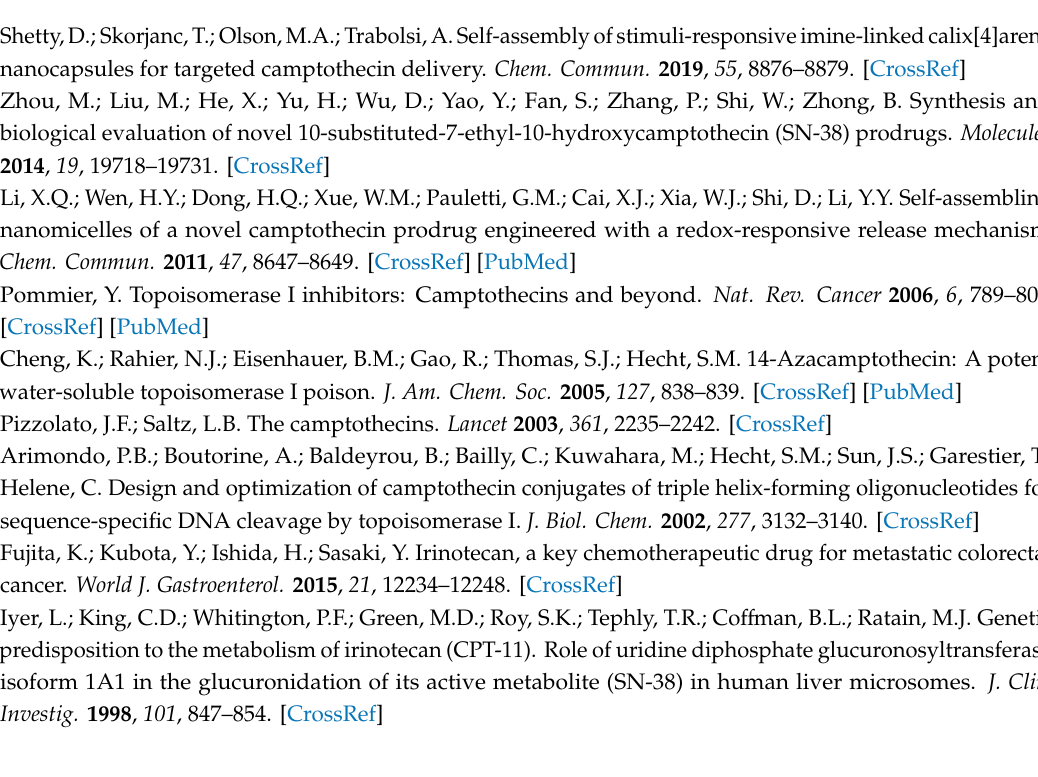
Figure S1: Metabolism of irinotecan to SN-38, Figure S2: Enzymatic synthesis of bApt through a primer extension reaction, Table S1: Synthetic oligonucleotides used in this